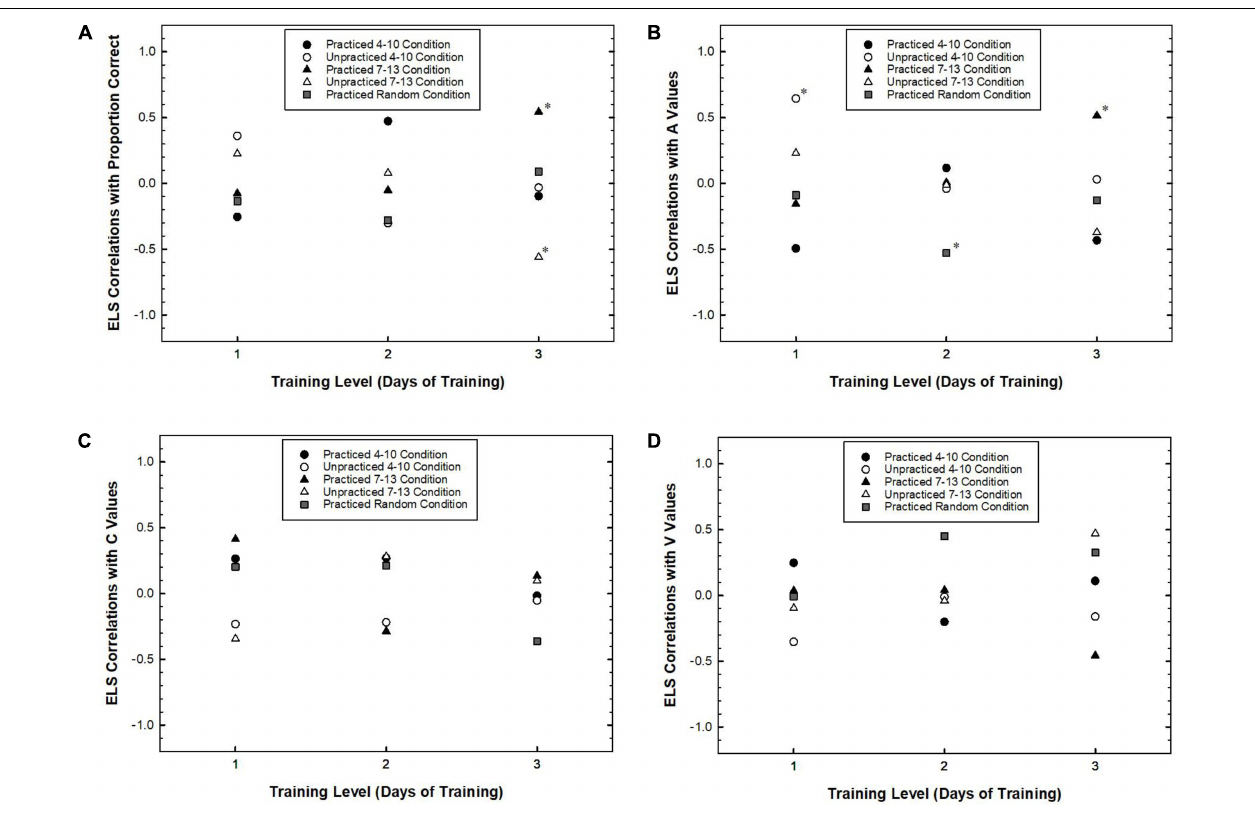
FIGURE 6 | The correlation between the transfer related Explicit Learning Score (ELS) and the rate of learning for target identification rate (A) , A values (B) , C values (C) , and V values (D) plotted as a function of Training Level separately for practiced and unpracticed Target Positions. Asterisks represent correlations that were statistically significant ( p < 0.05) or marginally significant ( p <